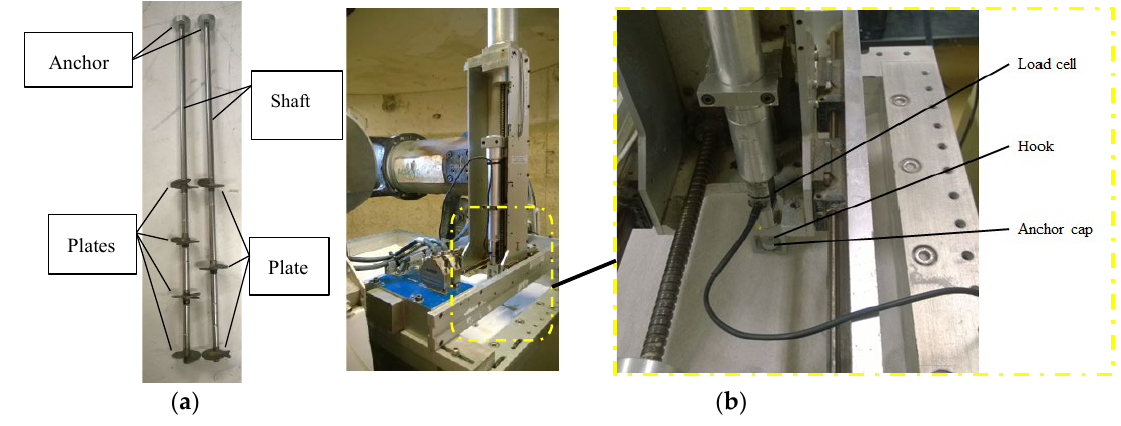
Figure 5. The test setup: ( a ) for the details about model anchors; ( b ) for the loading equipment. Table 1. The information about the helical anchor and soil [18]. Helical Anchor Soil